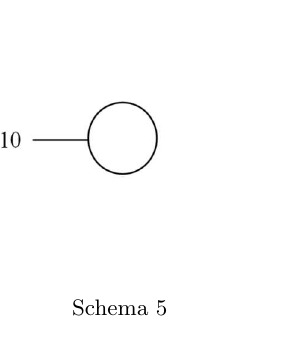
Schema 5 stands for a two-place basic formula: ⌊ p q ⌋ (pq),